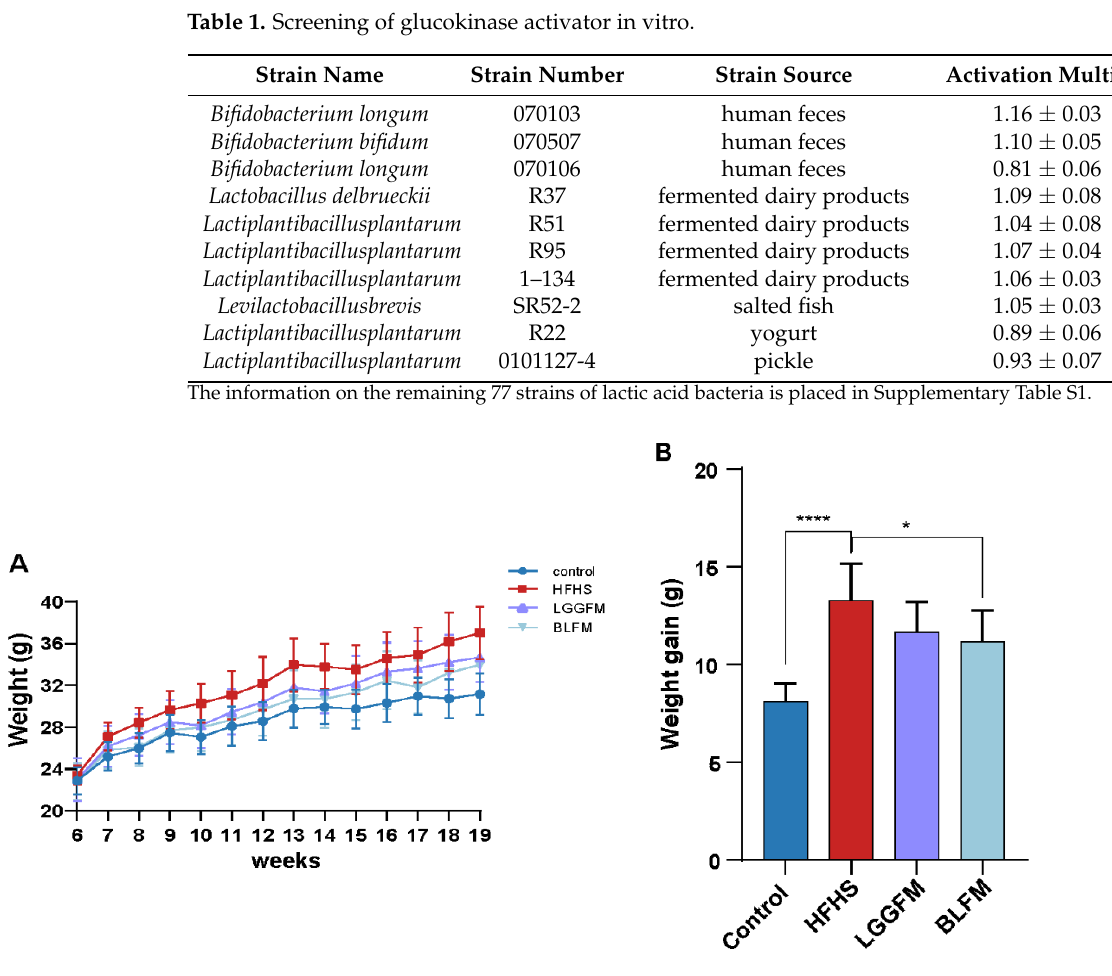
Figure 1. Effects of supplementing fermented milk on BW and weight gain: ( A ) BW change in mice at 13 weeks, ( B ) BW gain. Data are presented as means ± SD (n = 10) and analyzed using one-way ANOVA (* p < 0.05, **** p < 0.0001). Table 2. Indexes of organ and fat coefficient of mice in each group